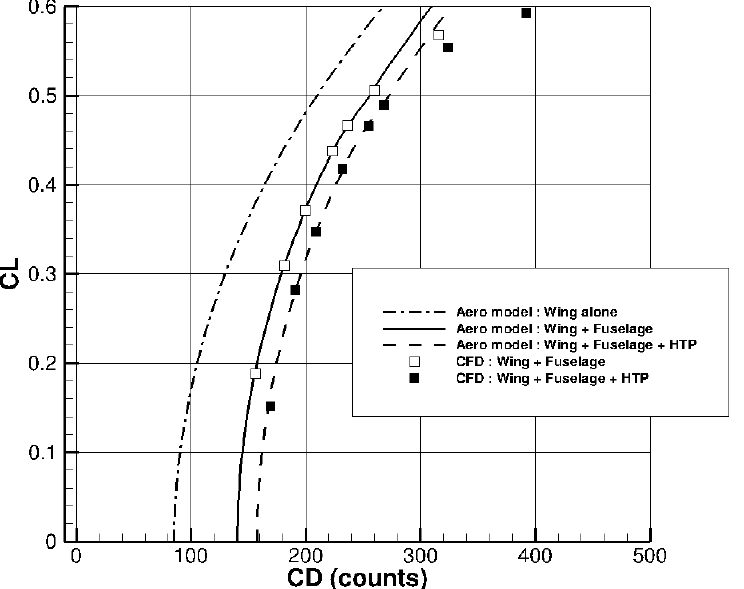
Figure 20. CRM configuration—C L (C D ) curves (M = 0.85, Re = 5 × 10 6 ). Lines—aerodynamic module; symbols—CFD.